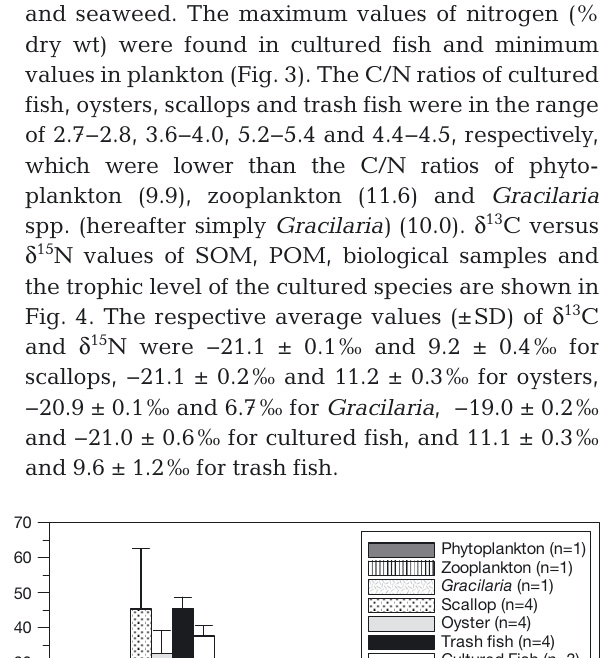
Fig. 2. Surface distribution of (a) salinity and (b) chlorophyll a in the 3 culture areas (see Fig. 1) in Sanggou Bay during the wet and dry seasons. Box plots show the median value (line), 25 and 75% quantiles (box), 5 and 95% quantiles (whiskers), and outliers (circles)